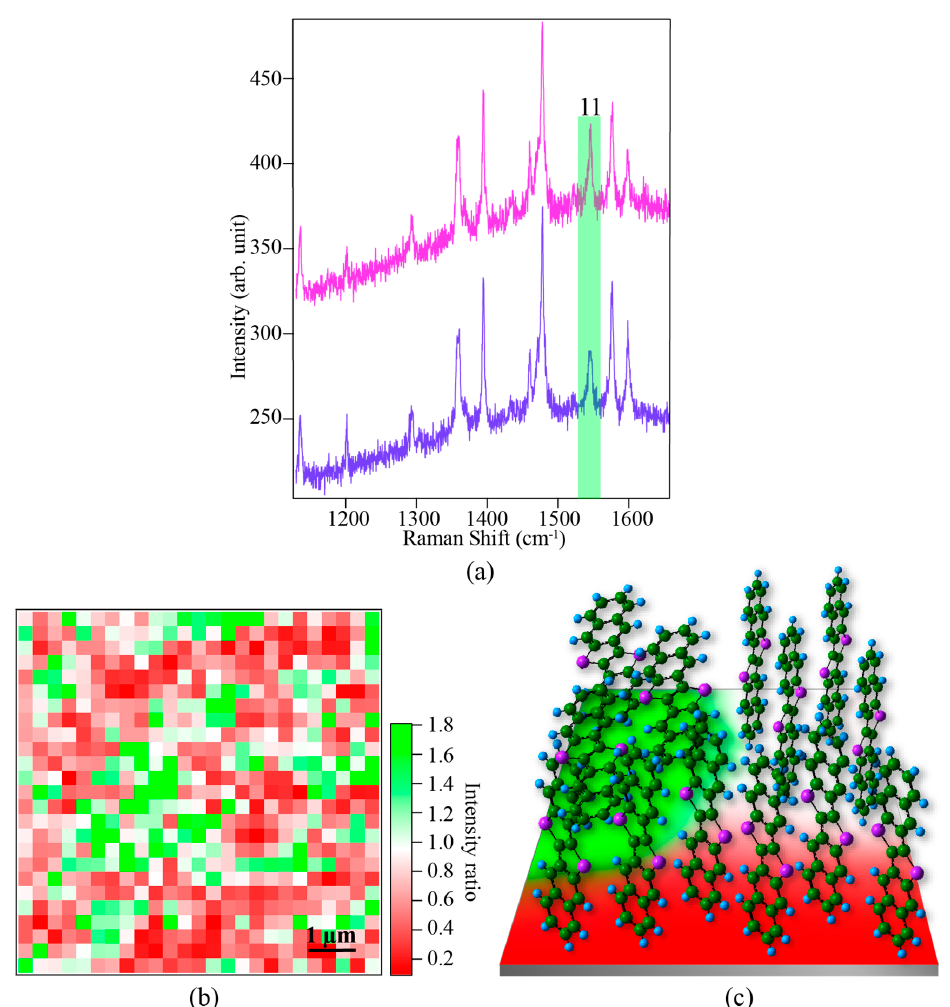
Figure 4. ( a ) Polarization-dependent Raman spectra with two mutually perpendicular linearly polarized light; ( b ) Raman intensity ratio image showing the distribution of molecular twist for the DNTT sample. The image was constructed by dividing Raman intensities of peak 11 obtained from the two mutually perpendicular linearly polarized light; ( c ) An illustration of the orientation of DNTT molecules in the device.